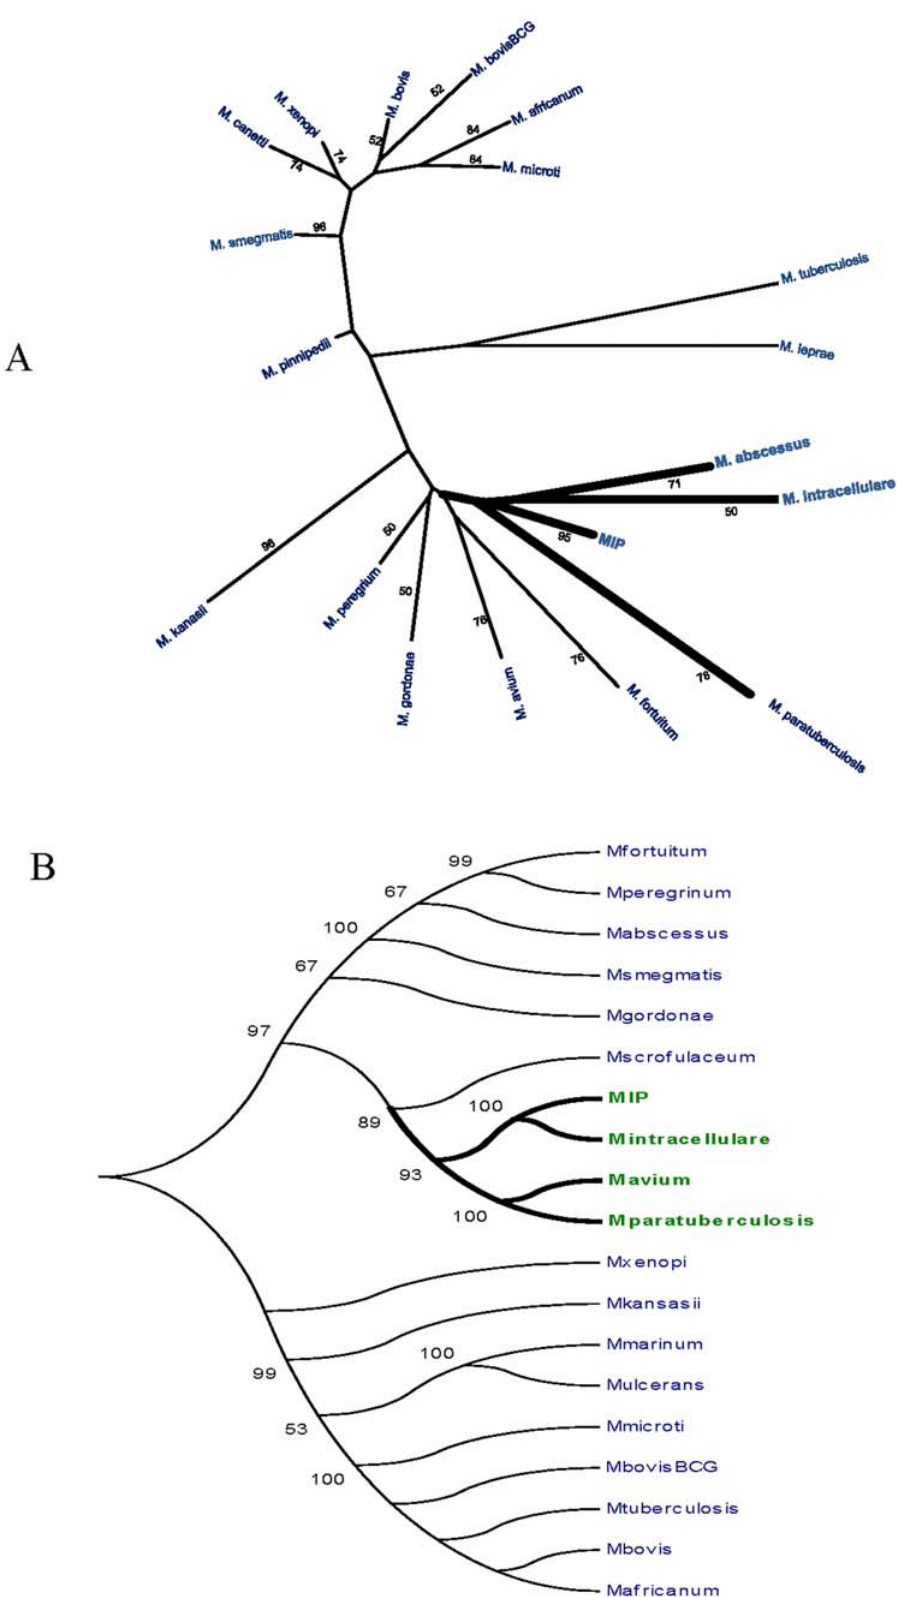
Figure 2. Phylogenetic trees based on FAFLP and multigene sequence analyses. A. Polymorphic fragments were subjected to allele calling in Genotyper (Applied Biosystems, USA) and allele scoring was recorded in a binary format. This binary data were used to construct a phylogenetic tree (please see methods). B. Phylogenetic tree constructed based on consensus multigene alignment which involved concatenation of individual gene sequences corresponding to rpo B, rec A, sod A, rrn 16 and hsp 65. Bootstrap values conveying significance of the internal branch topology are clearly marked near each branch. Values above 50 were deemed to be significant to convey correct topology of the internal branches. doi:10.1371/journal.pone.0000968.g002 PLoS ONE | www.plosone.org